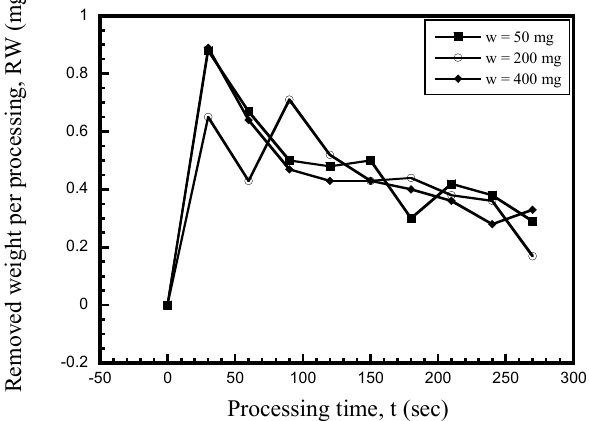
Figure 14. Variations of removed weight against processing time. (diamond paste size: 1 µm, frequency of magnetic poles: 12 Hz).